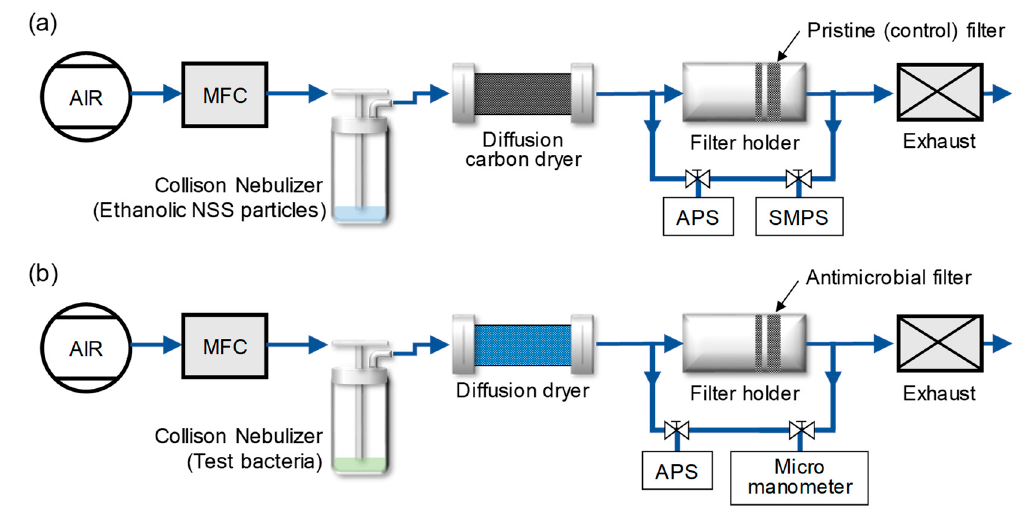
Figure 1. Experimental configuration of ( a ) the antimicrobial filter preparation system, and ( b ) the filtration test system.